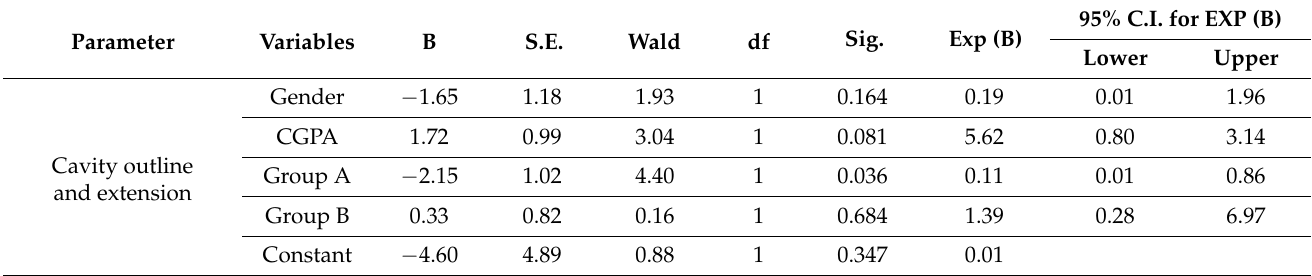
Table 6. Expressing the effect of cavity outline and extension parameter on gender, CGPA, Group A and Group B using binary logistic regression